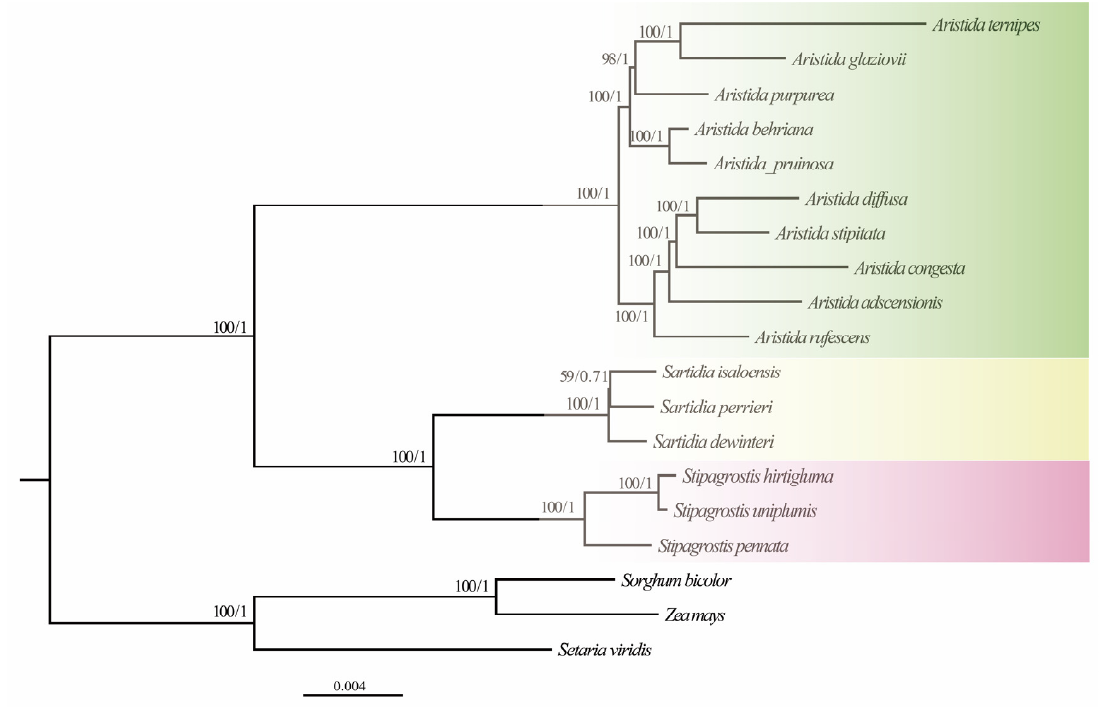
Figure 7. The Maximum Likelihood and Bayesian Inference trees of 16 Aristidoideae species based on their complete plastomes. The obtained bootstrap values (BS) and Bayesian Inference posterior probabilities (PP) are marked above the tree node (BS/PP).